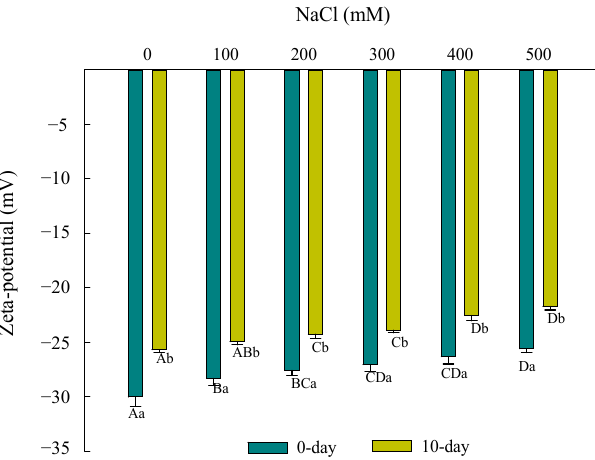
Figure 3. Effects of NaCl concentration on the zeta-potential of filled hydrogels during storage. Different letters from A to D indicate significant differences for different NaCl concentration at same days ( p < 0.05); Different letters from a to b indicate significant differences for different days at same NaCl concentration ( p < 0.05).